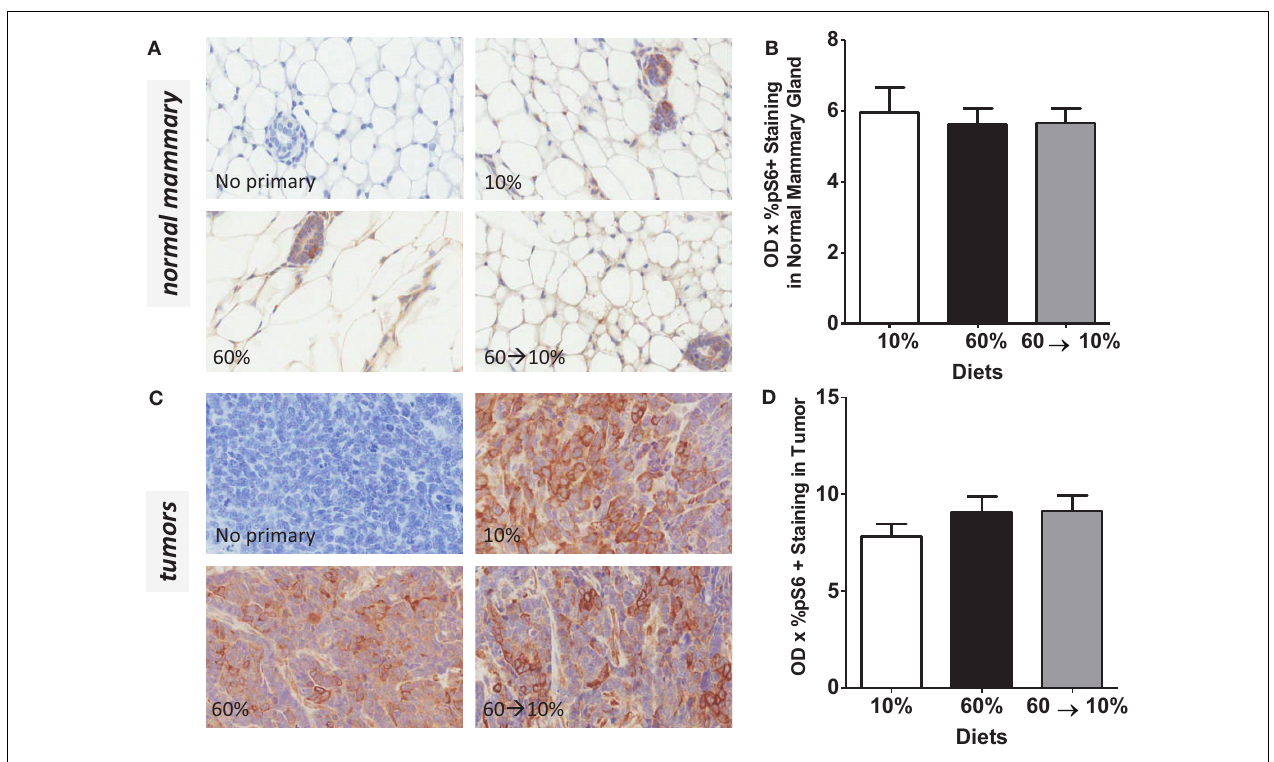
mammary glands and tumors in n = 2 sections from five mice using Aperio Imagescope software and the color deconvolution algorithm measuring positive pixel counts for diaminobenzidine (DAB)